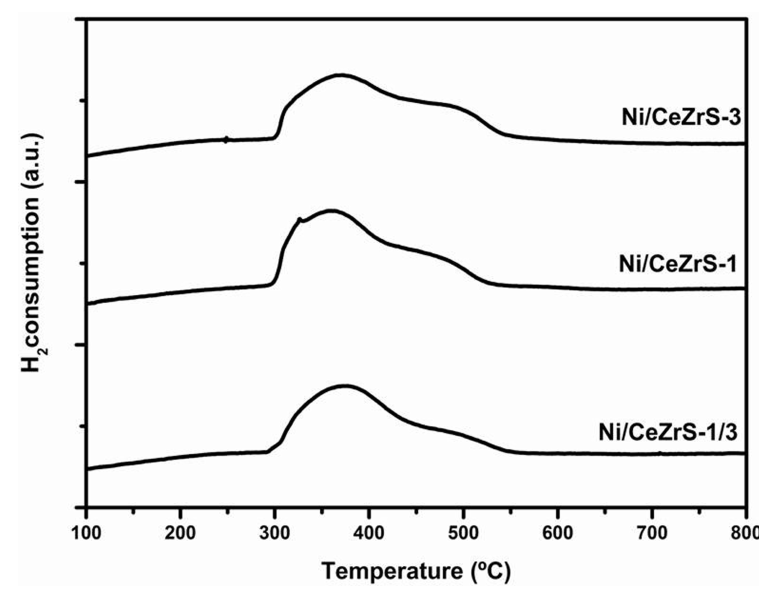
Figure 8. TPR profiles of the calcined Ni/Ce